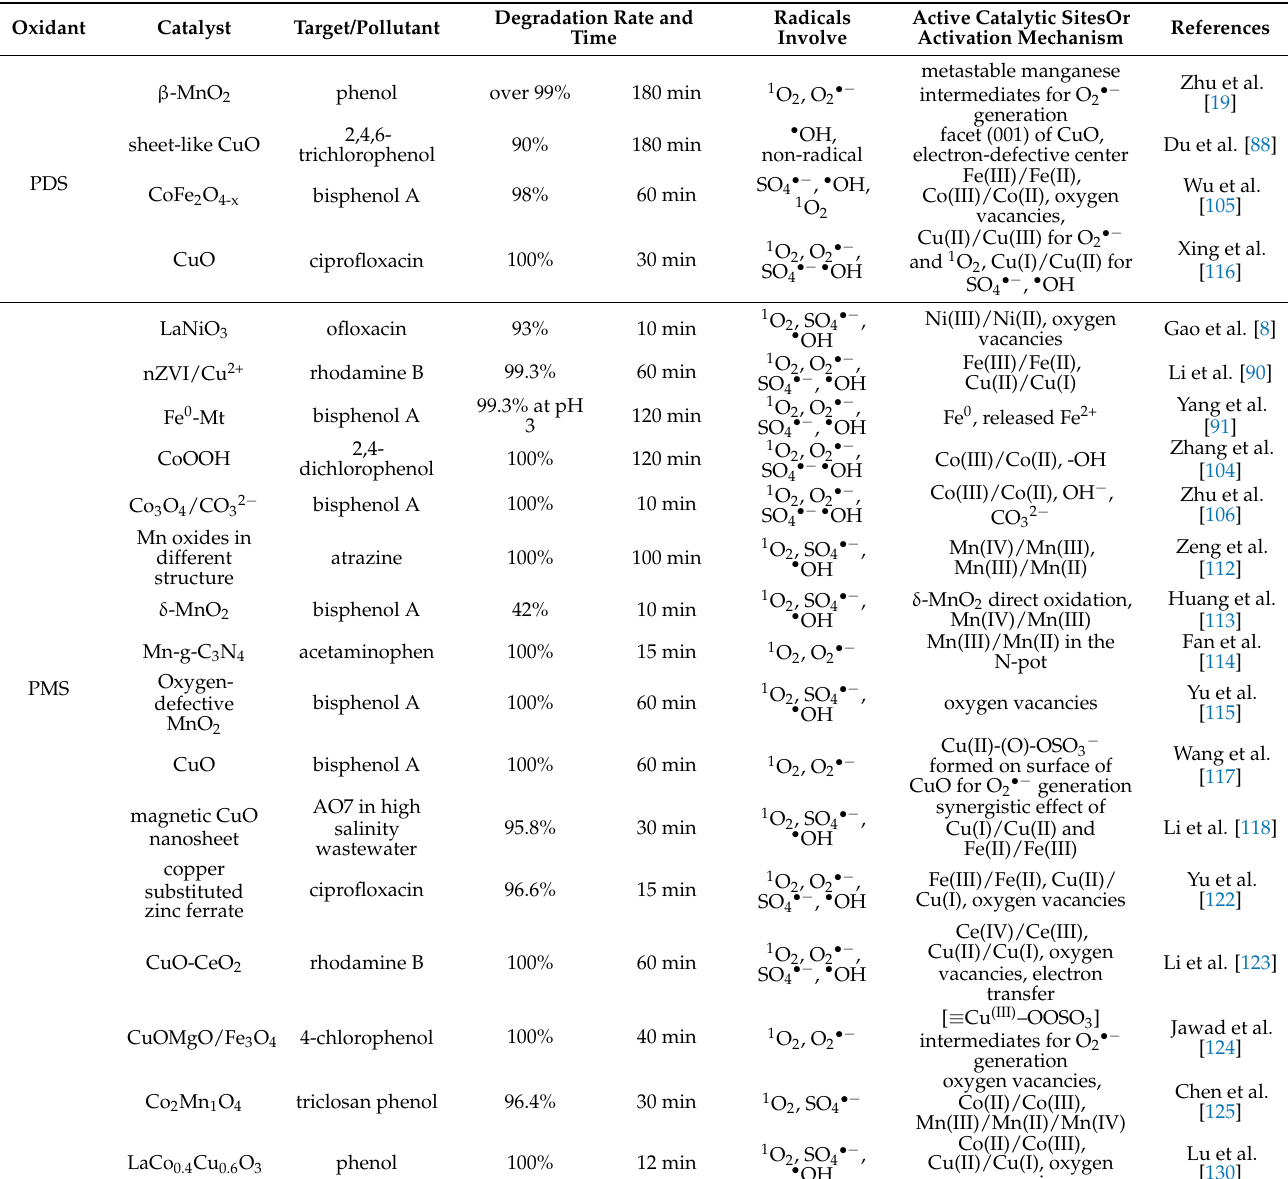
Table 3. Performance and mechanism of typical heterogeneous metallic catalysts for PDS/PMS oxidation of pollutants. Oxidant Catalyst